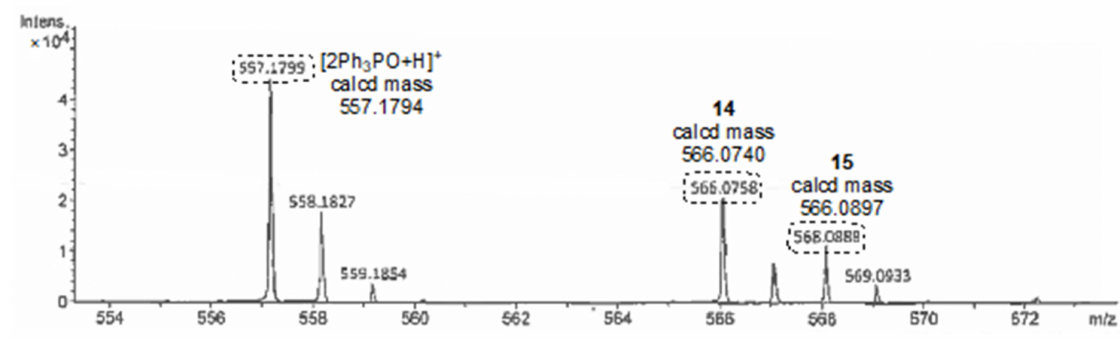
Figure 3. Mass result for Scheme 5, reaction 4; 14 , 15 -estimated benziodazolone derivative